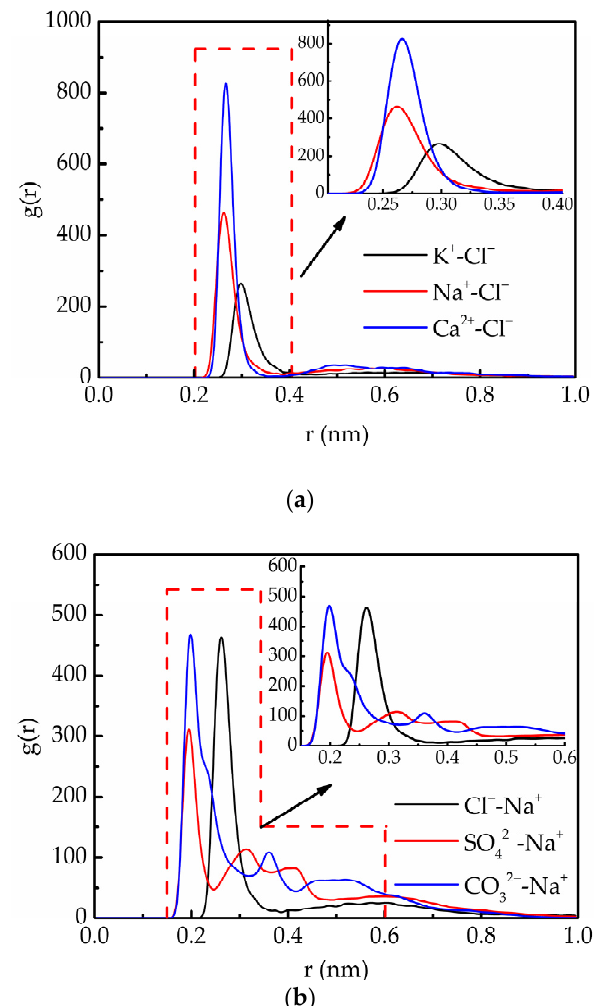
Figure 8. Radial distribution functions (RDFs) between solute ions: ( a ) RDFs between Na + , K + , Ca 2+ and Cl − ; ( b ) RDFs between Cl − , CO 32 − , SO 42 − and Na +.